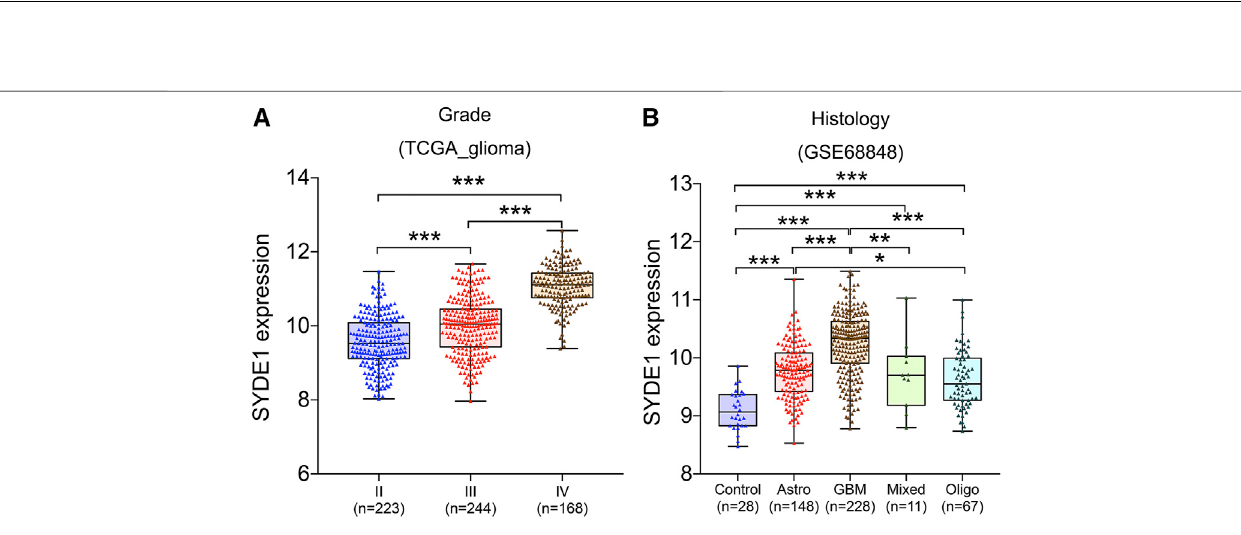
Frontiers in Molecular Biosciences |